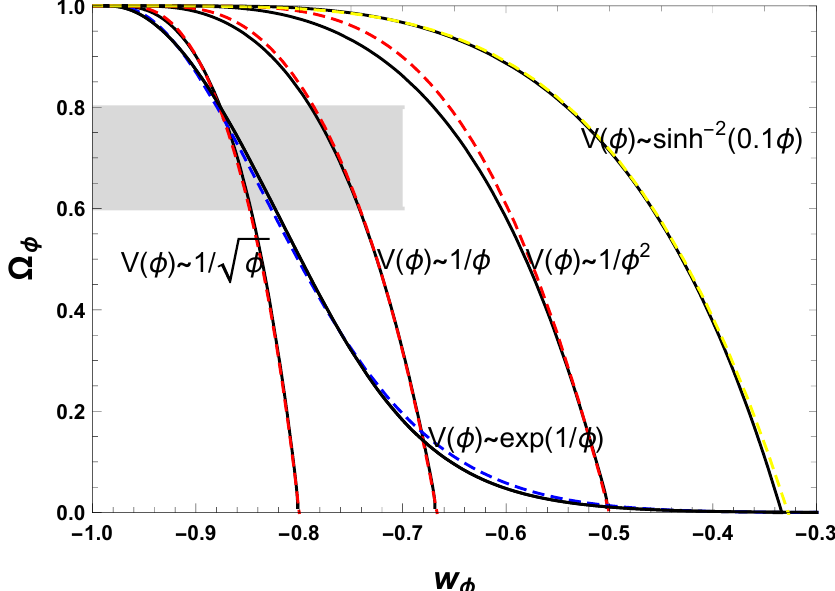
Figure 1. The w φ − Ω φ trajectories for the inverse power-law potential V ( φ ) ∼ φ − α , the potential V ( φ ) ∼ exp ( 1/ φ ) , and the potential V ( φ ) = V 0 sinh − 2 ( 0.1 φ ) with the tracking behavior. The dashed lines denote the analytical approximations (9)–(11). The shaded region is the allowed region